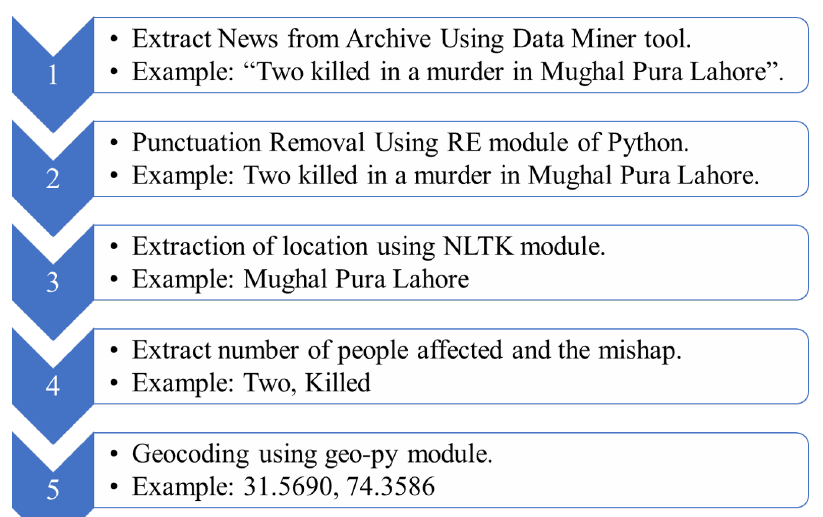
Figure 1. Flowchart of information extraction process with